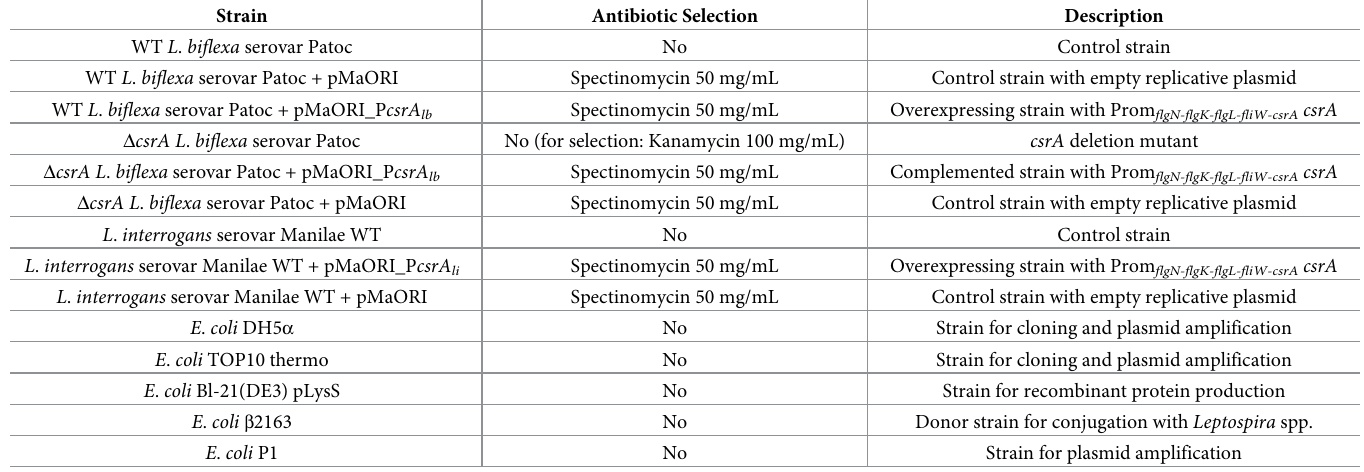
Table 2. Bacterial strains used in this